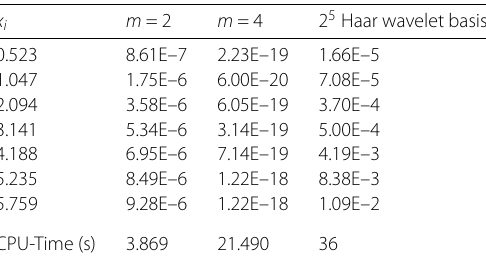
Table 3 Numerical results of Example 5.3